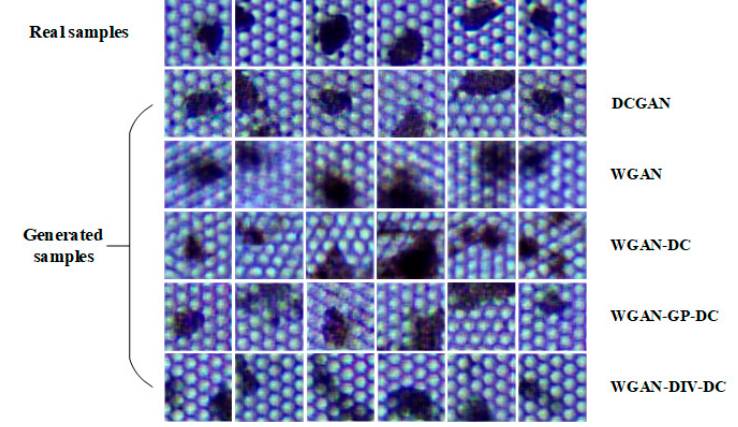
Figure 10. The real samples and the generated samples.